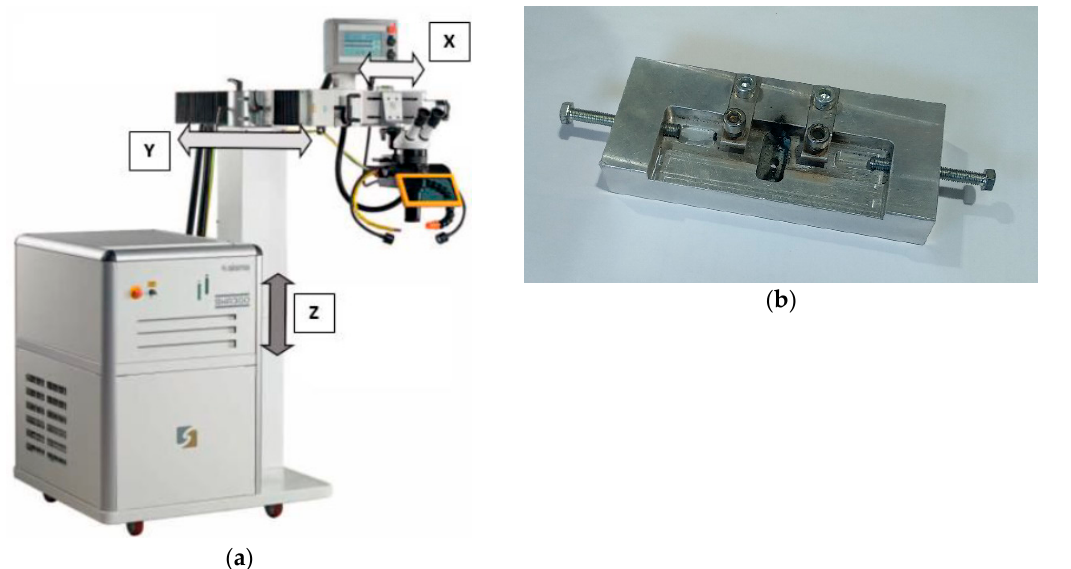
Figure 1. ( a ) SISMA SWA300 Nd:YAG laser welding machine; ( b ) Fixation/support system.